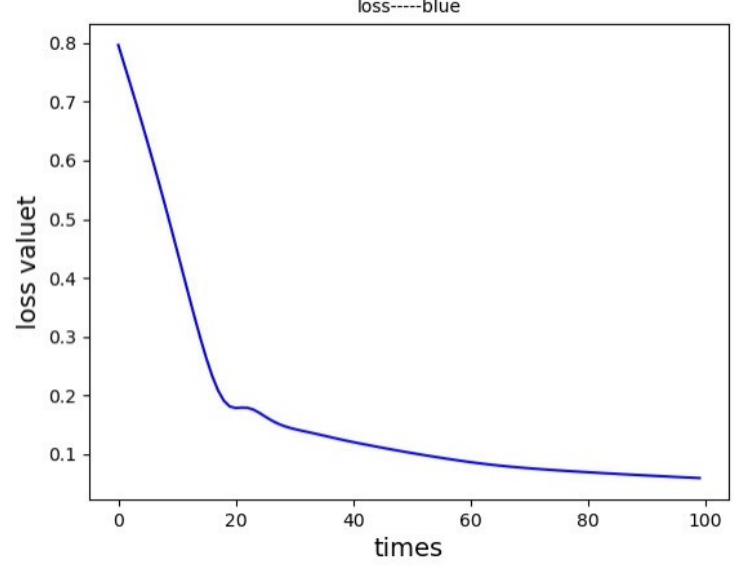
Figure 5. Model training